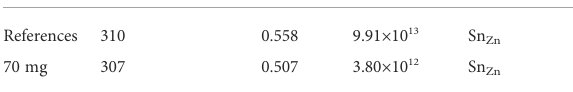
TABLE 2 Sn Zn deep defect metrics of the champion pristine CZTSSe device and Sb doped-CZTSSe device. Device